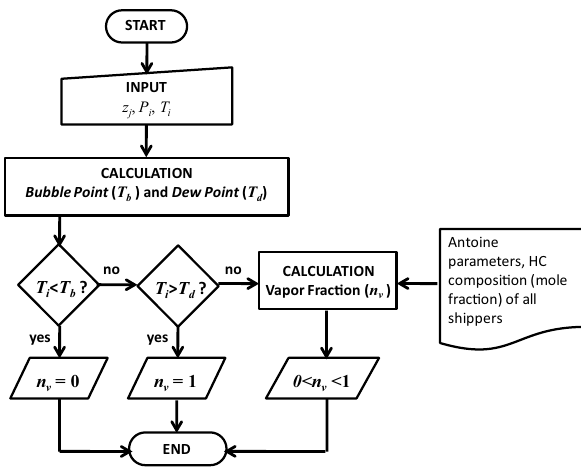
Fig. 5 Flash calculation